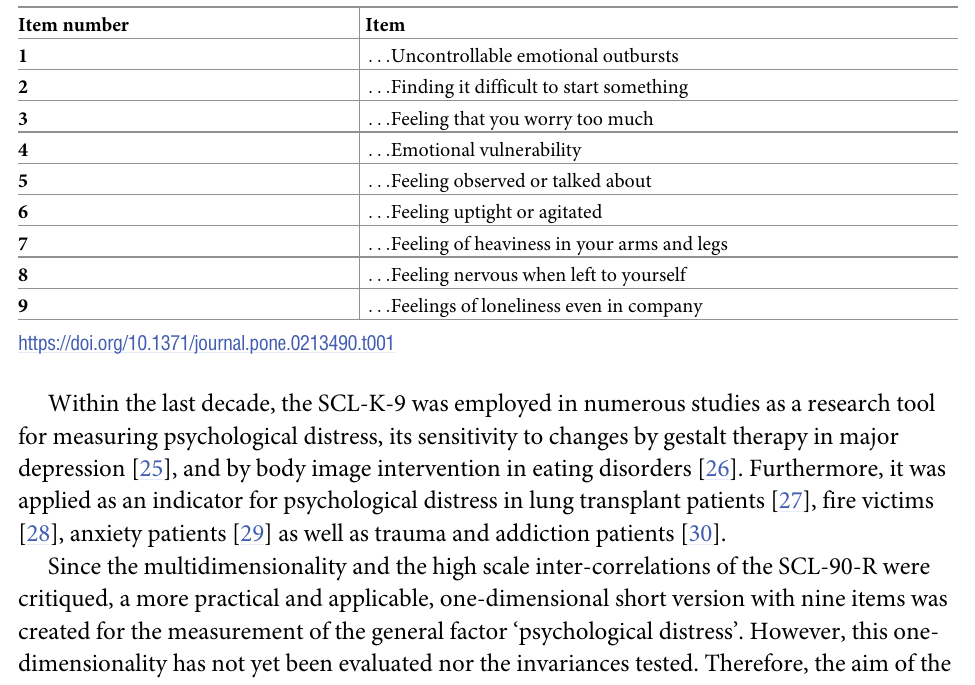
Table 1. Overview of the nine items of the